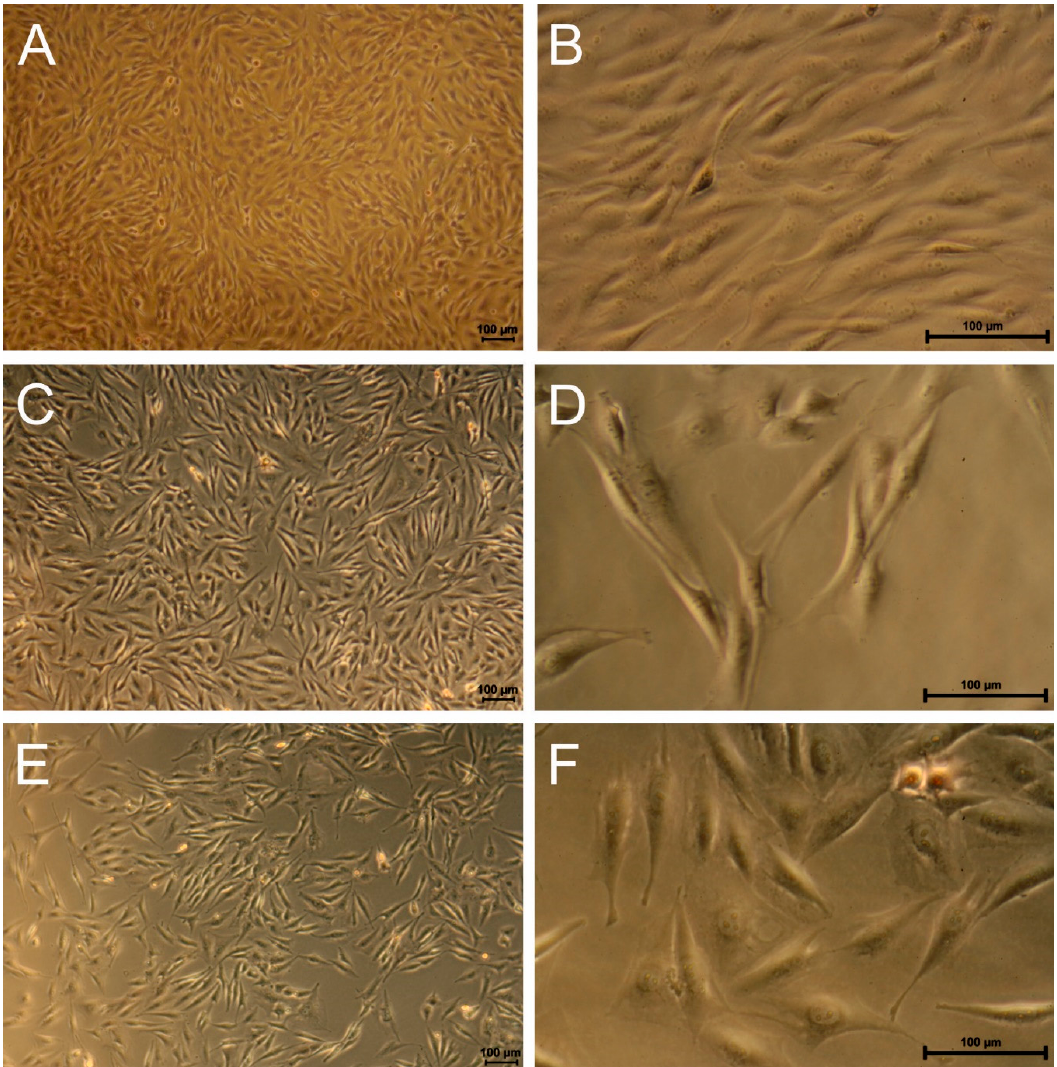
Figure 3. Light microscopy image s at different magnification of Alizarin red stained MG63 cells grown on ( A , B ) reference substrates, ( C , D ) FeDip10, and ( E , F ) on FeDip50 substrates at day 5.